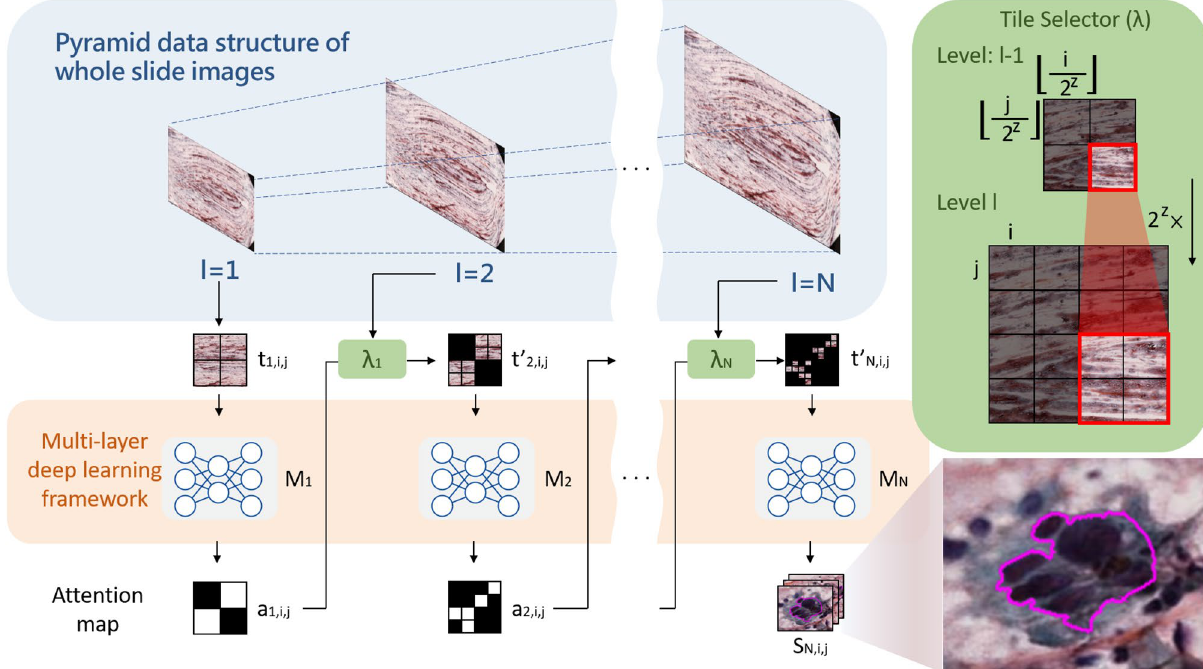
Figure 5. System framework. Each WSI is formatted into a tile-based pyramid data structure and the probability of HSILs at every level is generated by multi-layer deep learning framework. A multi-layer attention map is computed to select tiles of interest at every next level by a tile selector model (cid:31) , and the segmentation result of HSILs is generated by the last layer deep learning model M N ( t ′ N , i , j ( x , y ))